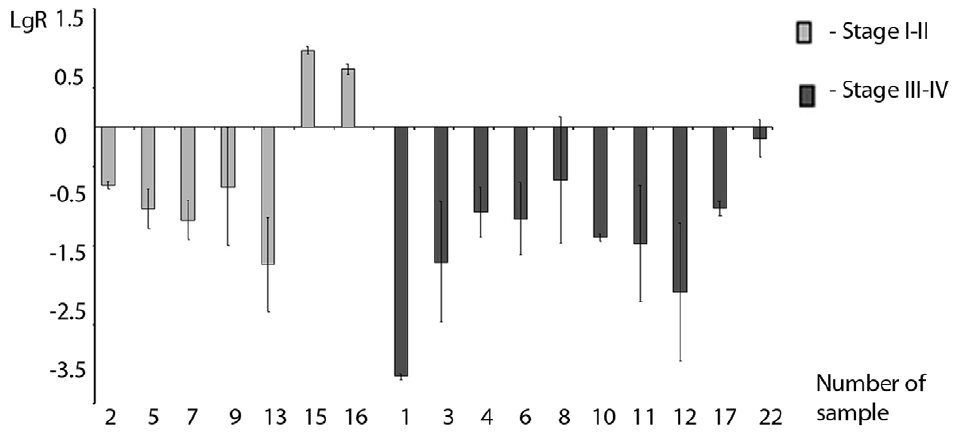
Figure 3. Panel of WNT7A gene expression in clear cell RCC samples. R – values of expression in the form of the logarithmic ratio of tumor/ normal tissue of the WNT7A gene relatively to the TBP gene.